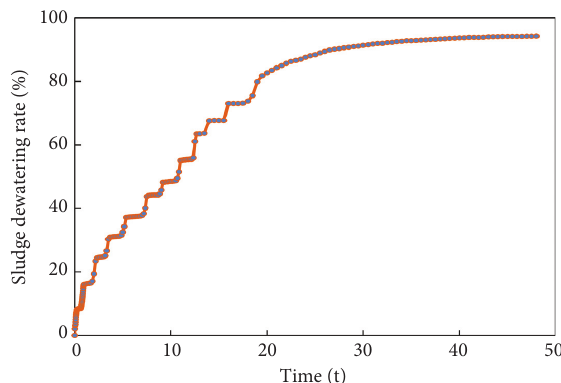
Figure 9: Sludge dewatering rate without